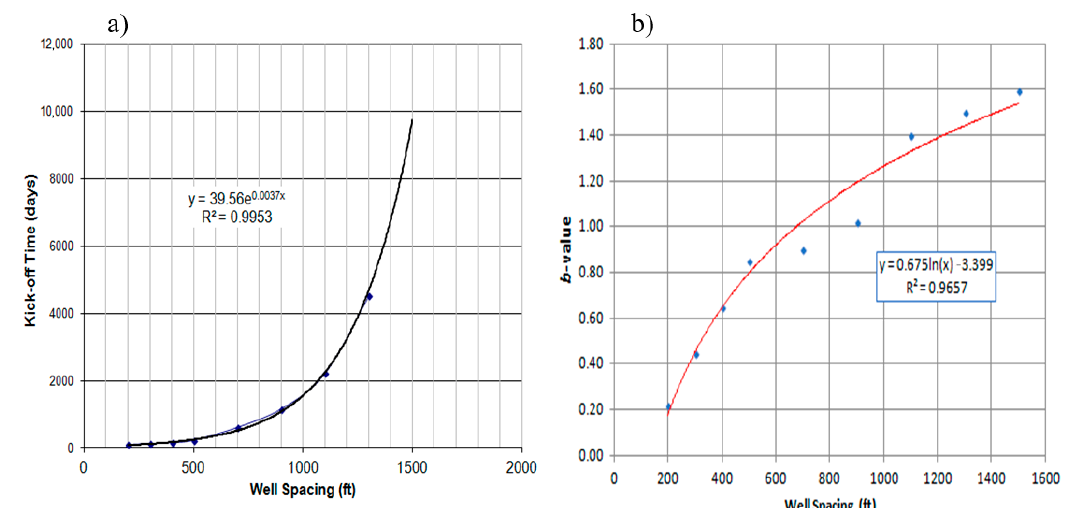
Figure 13. ( a ) Kick-off time variation with well-spacing between 200 and 1500 ft. The black curve is an exponential regression function fit to data. ( b ) b -value variation with well-spacing between 200 and 1500 ft. The red curve is the logarithmic function fit to data.